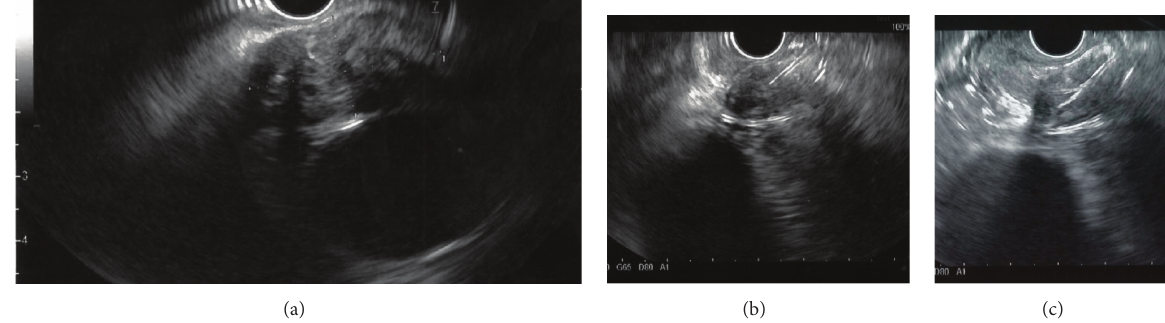
Figure 1: Subcarinal lymphadenopathy on transesophageal EUS (a). EUS-FNA attempt with a 19-gauge needle (b). EUS-FNA attempt with a 22-gauge needle (c).